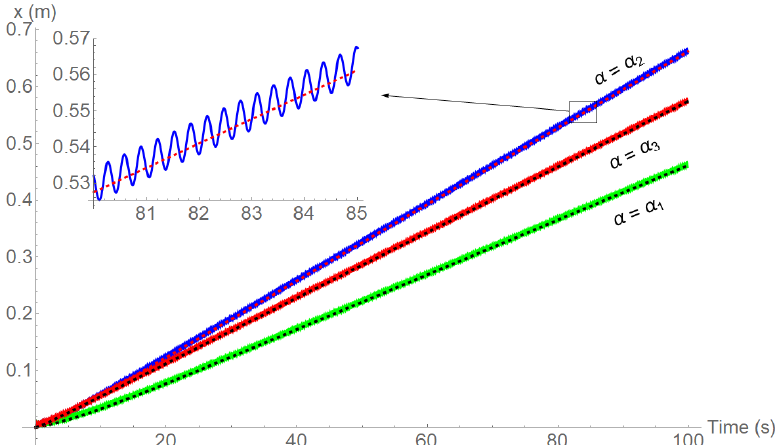
Figure 9. Displacement of the swimmer versus time with an asymmetric added mass for α 1 = 5 ◦ , α 2 = α m = 8.7 ◦ , and α 3 = 13 ◦ . Full: original system, dashed: averaged